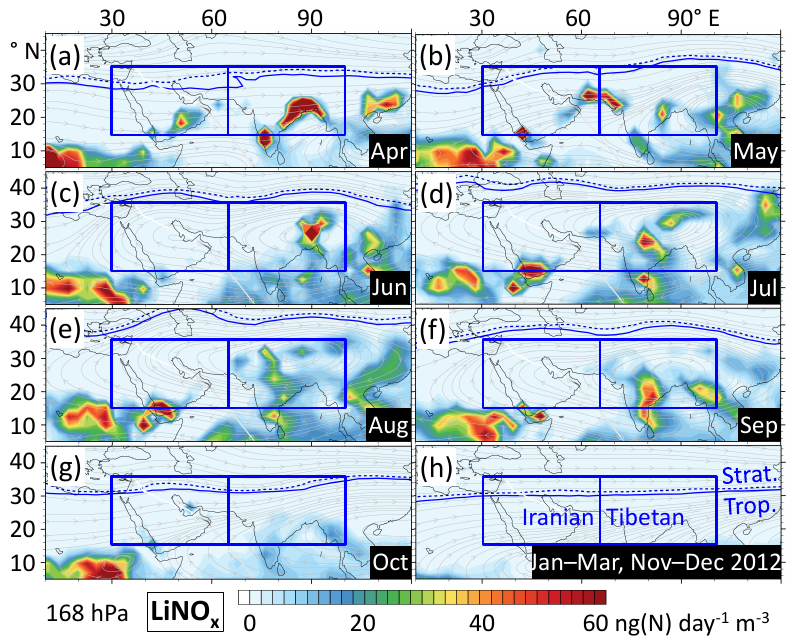
Figure 10. Simulated monthly mean lightning NO x emission rates in 2012 at a pressure level corresponding to the HALO ESMVal mea- surements. Months with almost no emissions are combined in panel (h) . The ASMA circulation dominates in the monthly mean wind fields from June to September, as shown by streamlines (grey). There are strong, localised emissions in spring (April–May), which in the Iranian part hardly reach the 355K level. In contrast, LiNO x emissions are distributed throughout the Tibetan region in summer (July–September). The simulated spatio-temporal emission patterns are similar for 2013 and 2014 (not